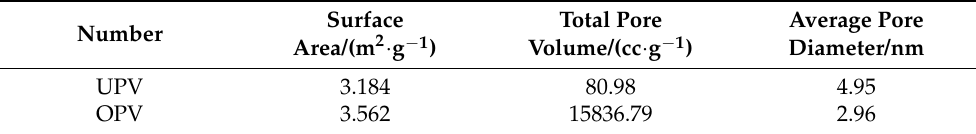
Table 4. Surface area and pore volume parameters of UPV and